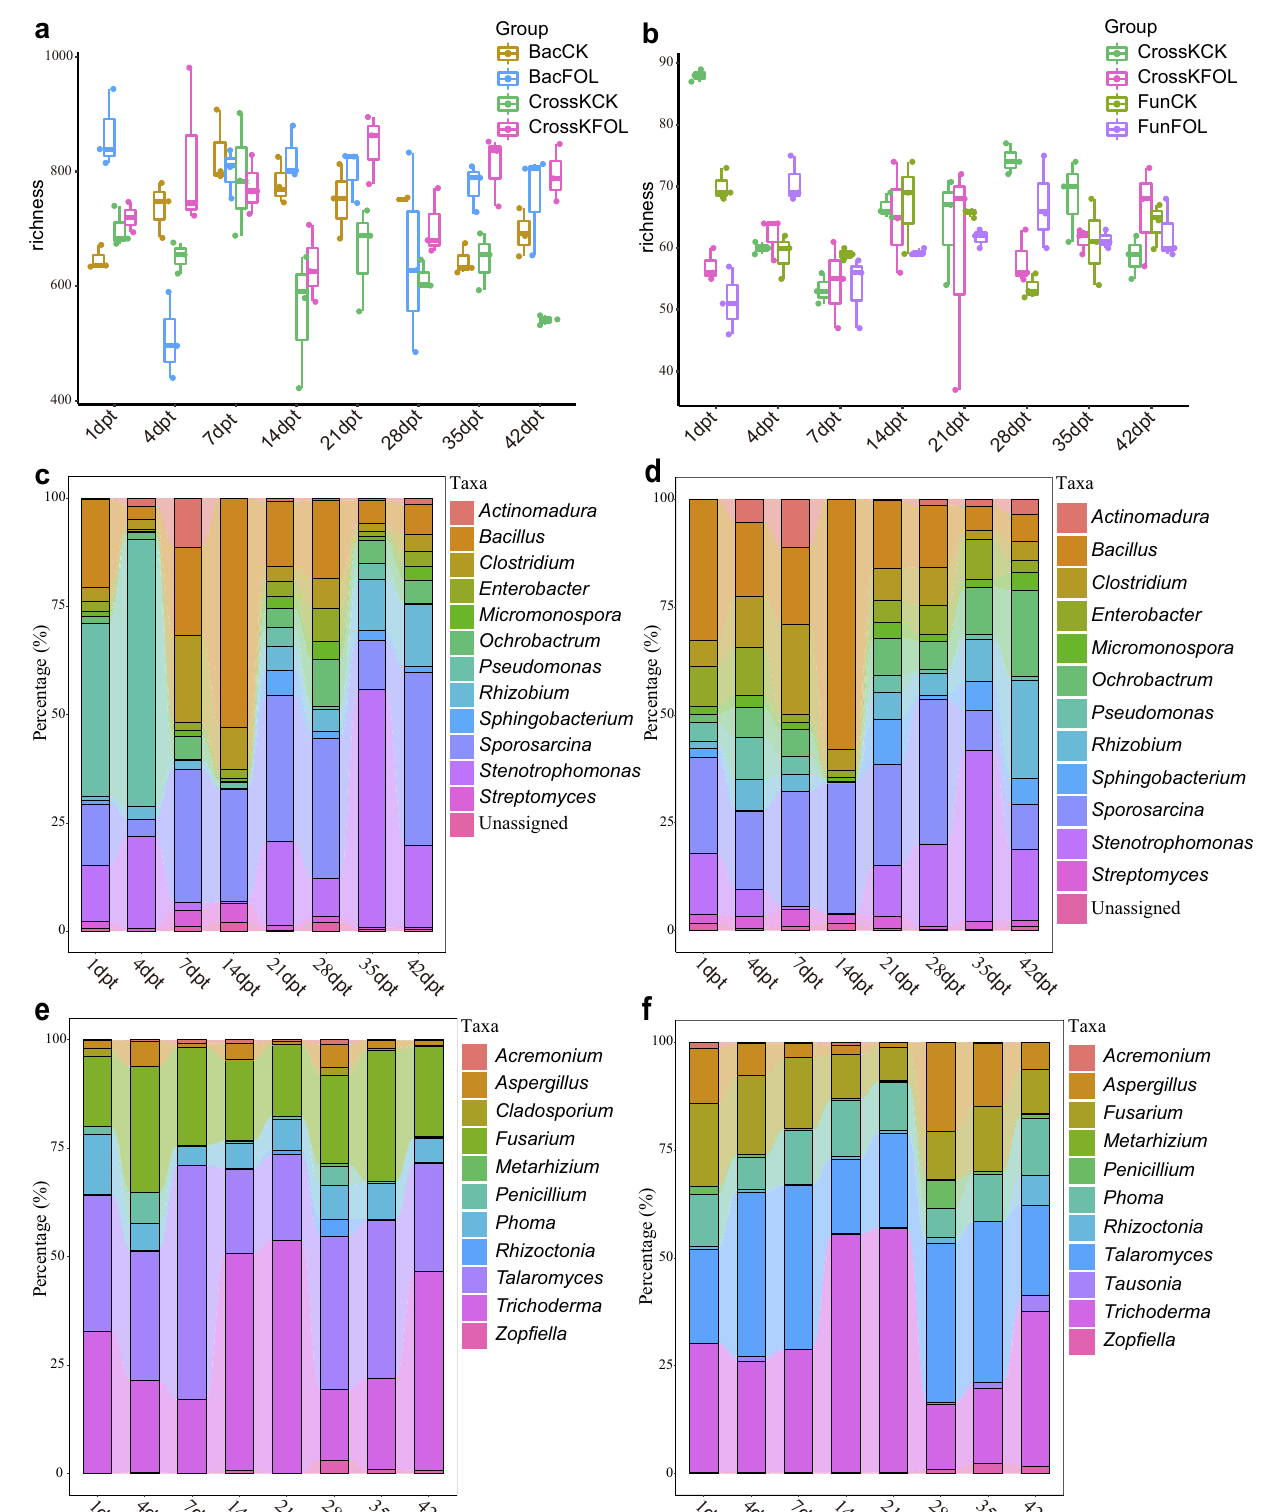
Fig. 5 | Longitudinal dynamics of bacterial and fungal communities in tomato seedlings after inoculation of different SynComs. a The dynamics of bacterial alpha diversity of CrossKCK, CrossKFOL, BacCK, and BacFOL ( n =3 biologically independent plants). b The dynamics of fungal alpha diversity of CrossKCK, CrossKFOL, FunCK, and FunFOL ( n =3 biologically independent plants). The hor- izontallineswithinboxesrepresentmedians;topsandbottomsofboxesrepresent the75 th and25 th percentiles;andupperandlowerwhiskersextendtodatanomore